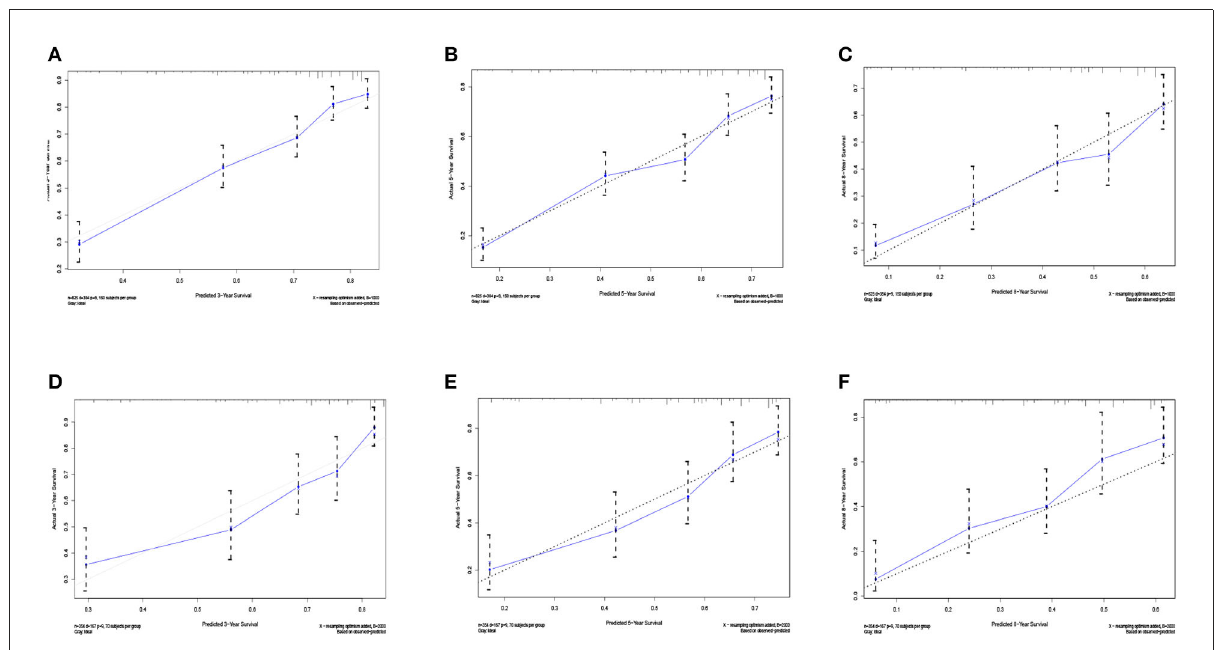
FIGURE4 The calibration curves for predictions of overall survival in the training set (A–C) and validation set (D–F) at 3, 5, and 8-year.